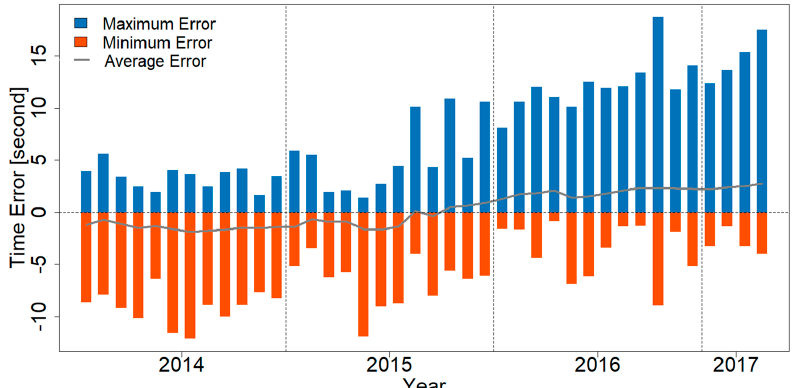
Figure 6. Monthly change of the time error for Eastern Interconnection (EI) system of North America from 2014 to 2017. The blue bar shows the maximum time error (positive value, i.e., running fast time error) in this month. The orange bar presents the minimum time error (negative value, i.e., running slow time error) in this month. The grey line indicates the average time error over one month.